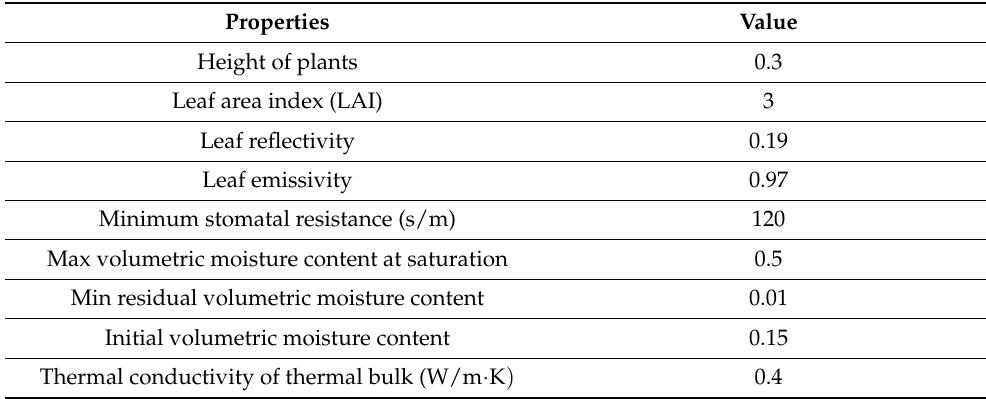
Table 7. Green roof parameters.